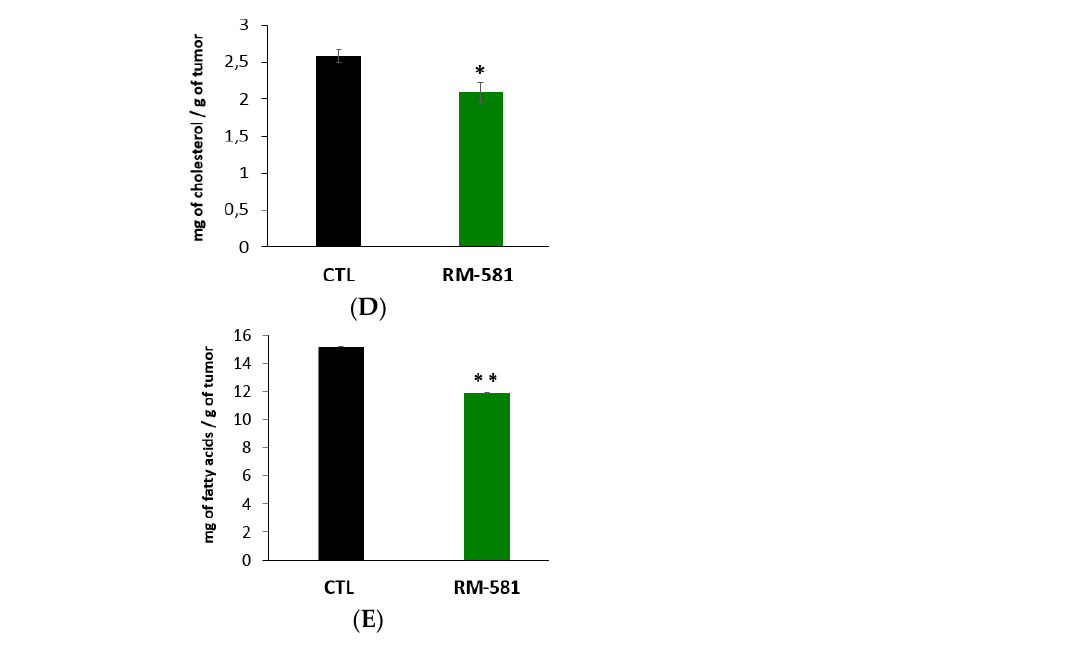
Figure 6. RM-581 blocks tumor growth in mice (PC-3 xenograft model). ( A ) Effects of RM-581 (15 mg/kg) administered orally (PO) 6 days per week with docetaxel (4 mg/kg) administered IP twice a week. Tumor sizes expressed as the per- centage of initial tumor size (day 1 of treatment: 100%). Data are the mean ± SEM ( n = 10–12 tumors and 6–7 mice per group). ( B ) Body weight of mice before and after treatment (30 days). Mice treated as in Figure 6A. ( C ) Effect of RM-581 on PC-3 xenograft tumors treated 30 days with docetaxel as in Figure 6A and next with RM-581, administered alone in day 38–48 at 30 mg/kg/PO, 6 days per week. Dashed line (gray) represents an extrapolation of docetaxel response from day 38 to 48. ( D ) Effect of RM-581 treatment at 15 mg/kg/day/PO during 30 days on cholesterol levels in PC-3 tumors. ( E ) Effect of RM-581 treatment at 15 mg/kg/day during 30 days on fatty acid levels in PC-3 tumors. * p < 0.05, ** p < 0.01 vs. control (CTL).